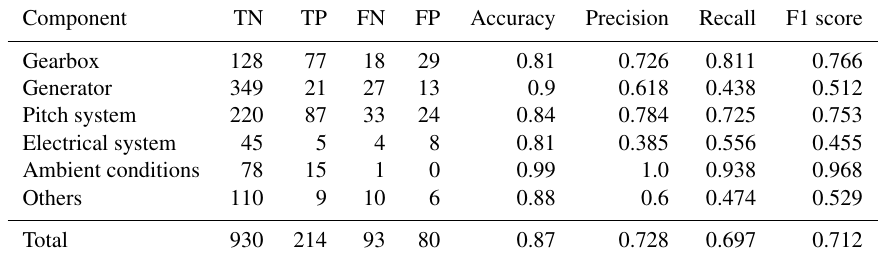
Table C2. Results selection per component for best configuration (Laplace/SD-max/ α cost = 80) on 1-year